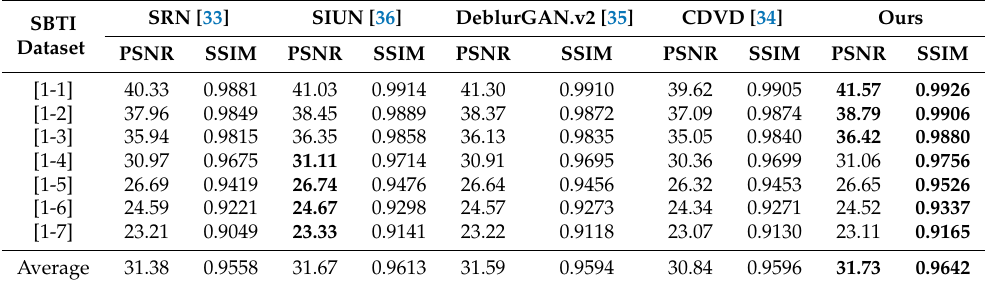
Table 4. Comparison of quantitative deblurring performance on the SBTI dataset [1-1]–[1-7].